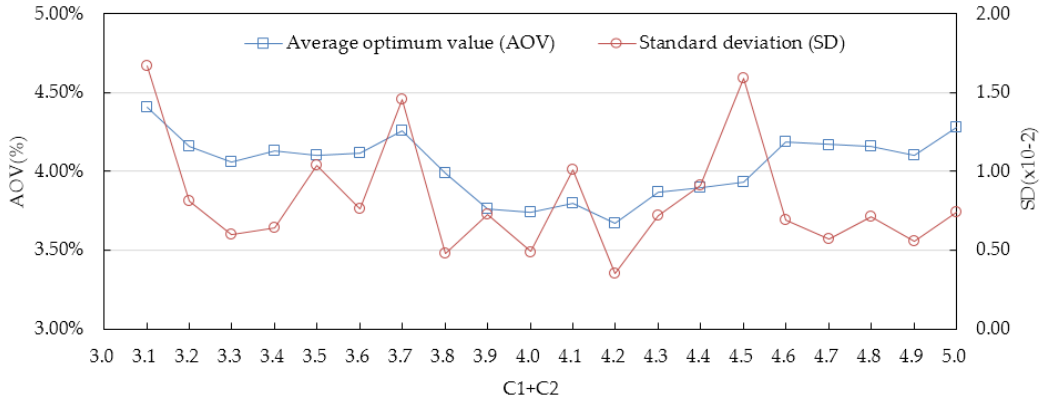
Figure 6. The curves of the average optimum value (AOV) and standard deviation (SD) for 100 trials of different values of c 1 + c 2 .